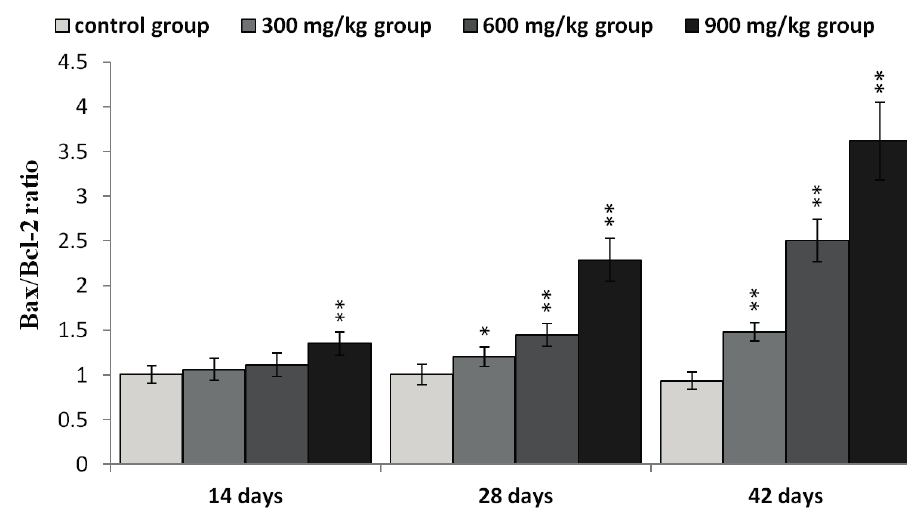
Figure 11. The ratio of Bax/Bcl-2 protein expression in the kidney. Data are presented with the mean ± standard deviation ( n =5 × 5); * p < 0.05, compared with the control group; ** p < 0.01, compared with the control group.